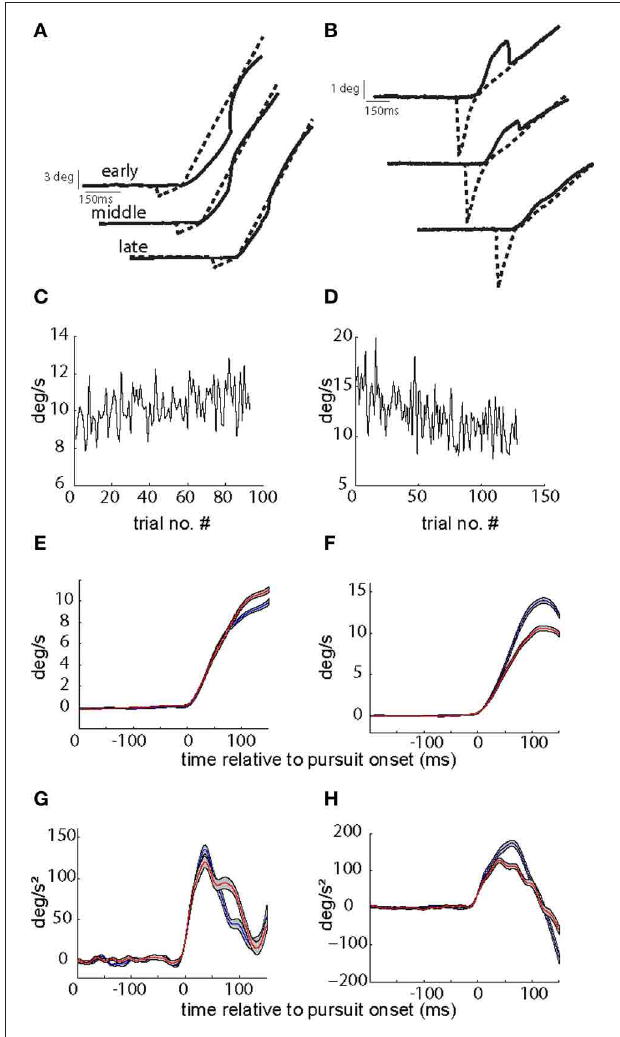
FIGURE 1 | Kinematic changes associated with gain-increase (A,C,E,G) and gain-decrease SPA (B,D,F,H). (A,B) Show exemplary target and eye position traces from early, middle, and late in the session during gain-increase SPA (A) and gain-increase SPA (B) . (C,D) Plot peak eye velocity (in the first 150ms after SPEM onset) as function of trial number during the course of SPA. Peak velocity increases during the course of gain-increase SPA (C) and decreases during gain-decrease SPA (D) . (E,F) Show the average velocity profiles (with standard errors) in the first (blue) and last (red) quarters of adaptation sessions leading to gain-increase SPA (E) or gain-decrease SPA (F) . Note that that peak velocity is not attained in the first 100ms during gain-increase SPA. (G,H) Depict the average acceleration profiles (with standard errors) in the first (blue) and last (red) quarters of adaptation sessions leading to gain-increase SPA (G) or gain-decrease SPA (H) . While gain-increase SPA is brought about by prolonging the acceleration duration, a drop in peak acceleration is responsible for gain-decrease